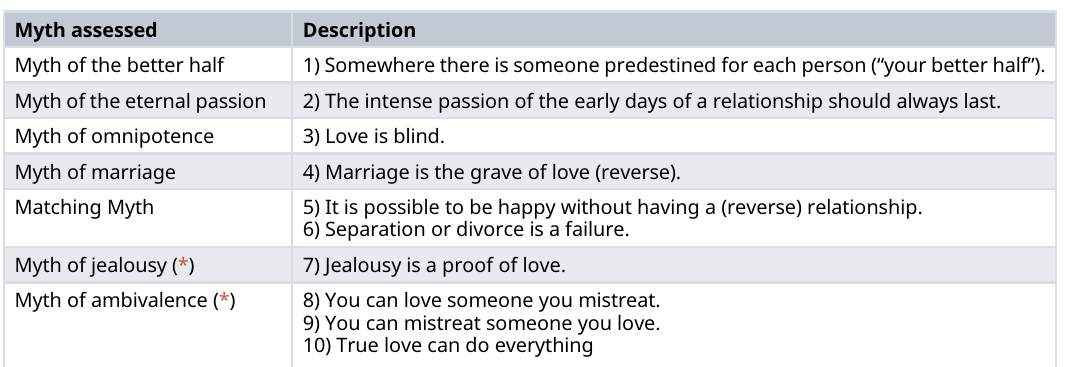
Table 1. Description of myths about romantic love. Source: (Ferrer et al. , 2010, p.13-14). Myth assessed